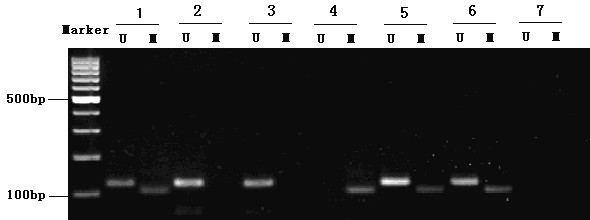
MSP results of DDIT3 gene in CML. U and M represent PCR results by using primer sets for methylated and unmethylated DDIT3 gene, respectively. 1: positive control (positive controls of methylation and unmethylation are genomic DNA of placenta which is modified with or without M.SssI); 2: sample of one BM donor; 3,4: samples of two cases at CP; 5: sample of one case at AP; 6: sample of one case at BC; 7: ddH2O; Mark: Gene Ruler™ 100 bp DNA Ladder.